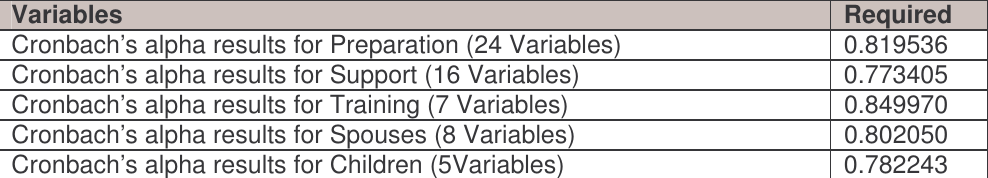
Table 1: Cronbach’s alpha values